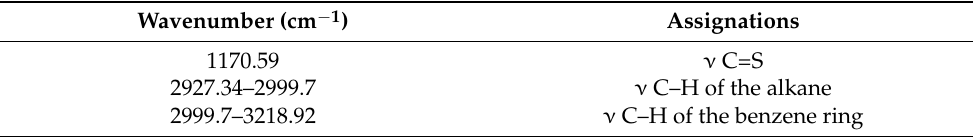
Table 5. Assignations of the bands of the asphaltene molecule vibration